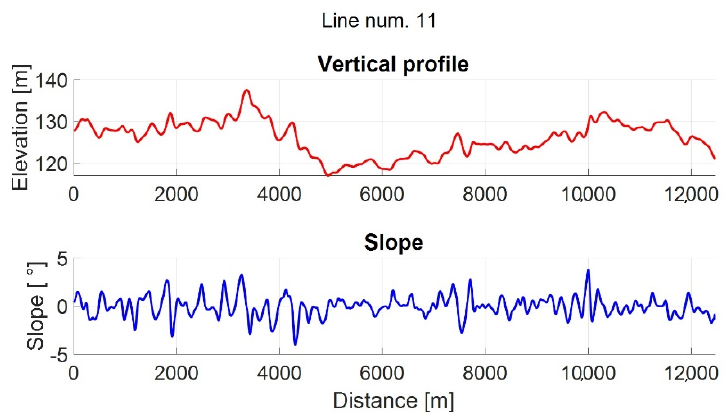
Figure 11. Track elevation profile and slope of line No. 11.